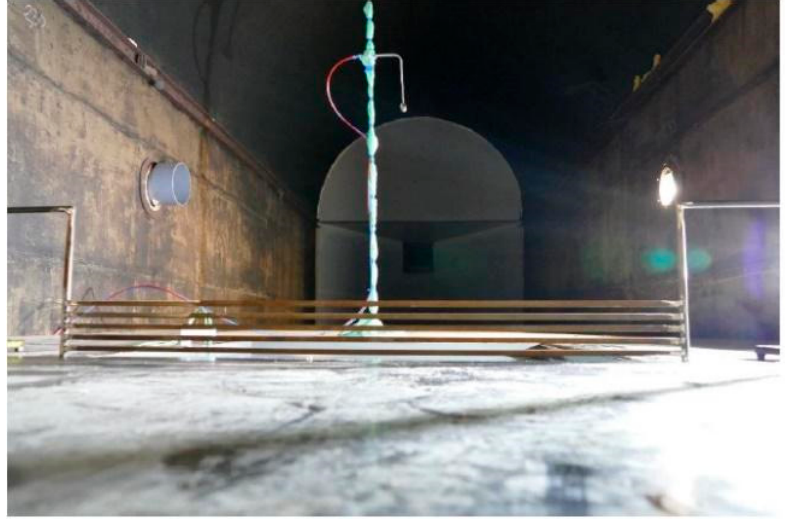
Figure 5. Picture of the system used to generate artificial turbulence upstream of the pool.